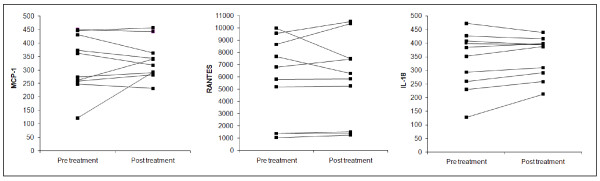
Serum levels of cyto-chemokine at baseline and after 1 month of therapy in SC patients. The serum levels of MCP-1, RANTES and IL-18 in 10 SC patients before and after atypical antipsychotic short-term monotherapy. MCP-1, RANTES and IL-18 levels were assayed in duplicate using a commercial ELISA a kit.